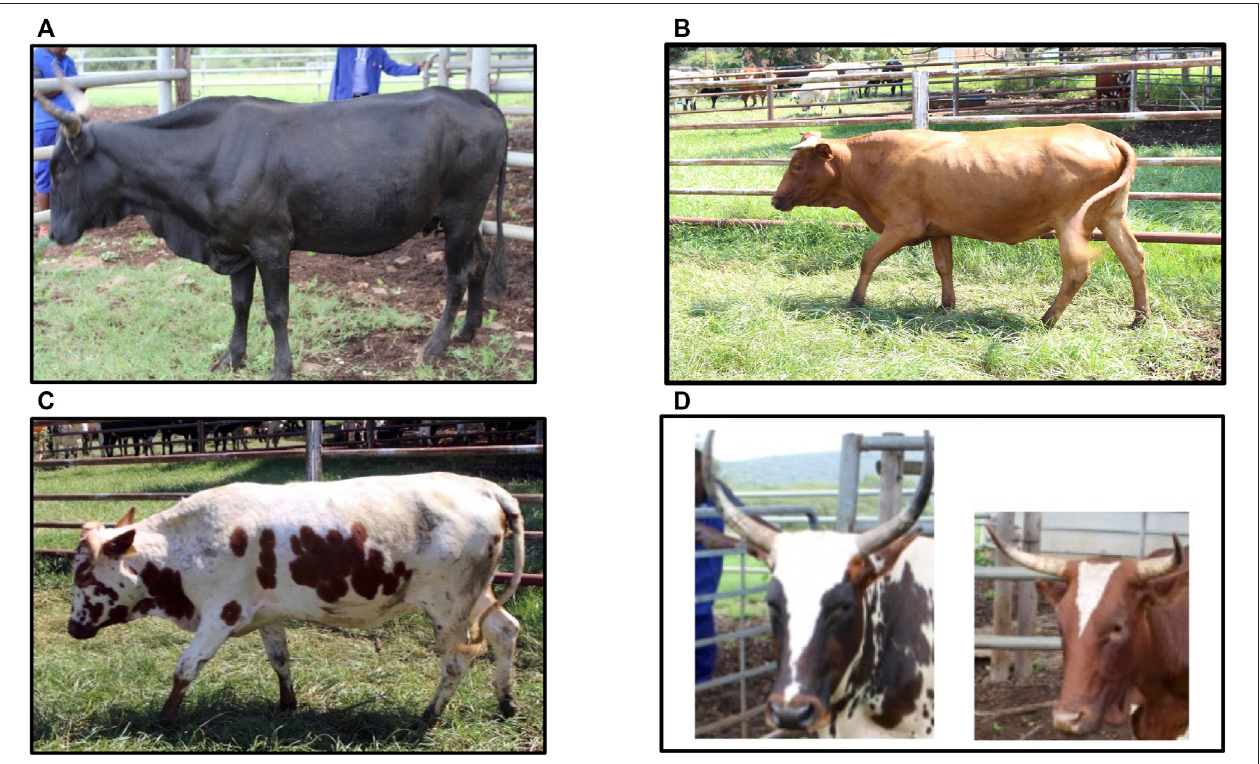
FIGURE 1 | Nguni cattle depicting base coat colours and the colour-sidedness and the white forehead stripe pattern. (A) Black (eumelanin) coat coloured Nguni cattle, (B) Red (pheomelanin) coat coloured Nguni cattle, (C) A colour-sided Nguni cattle, (D) white forehead stripe observed in Nguni cattle.